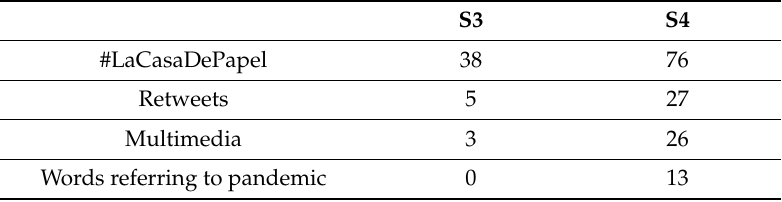
Table 3. Summary of the content analysis of the Twitter profile of Money Heist.